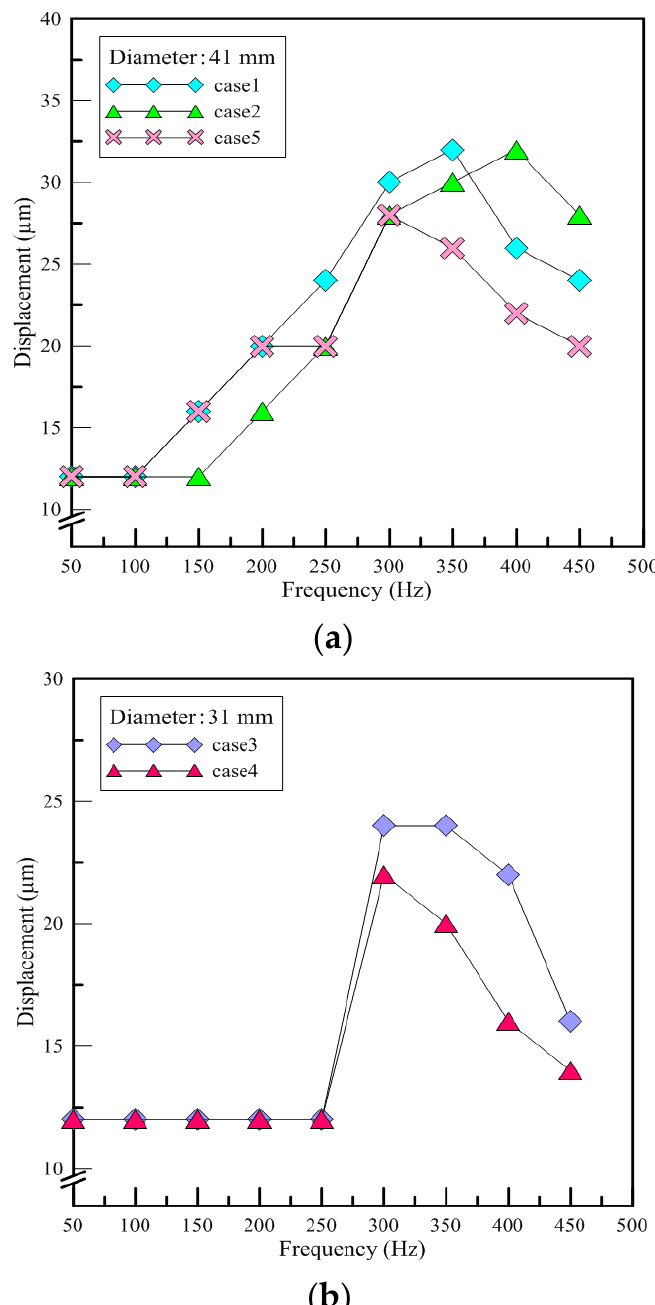
Figure 9. The results of displacement measurement. ( a ) Case1, case2, case5 ( b ) Case3, case4